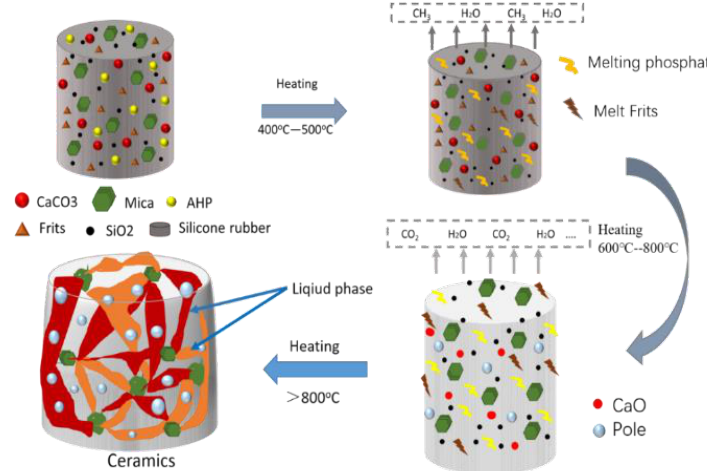
Figure 9. Ceramic expansion mechanism of